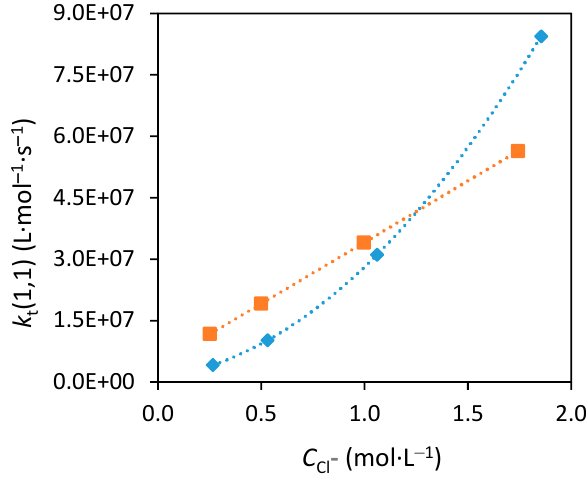
Figure 6 . Estimated variation of k t (1,1) as a function of counterion concentration from fits to TMAEMC ( ♦ ) [27] and MAPTAC ( ) [26] homopolymerizations carried out at 50 °C and varying initial monomer content in aqueous solution .